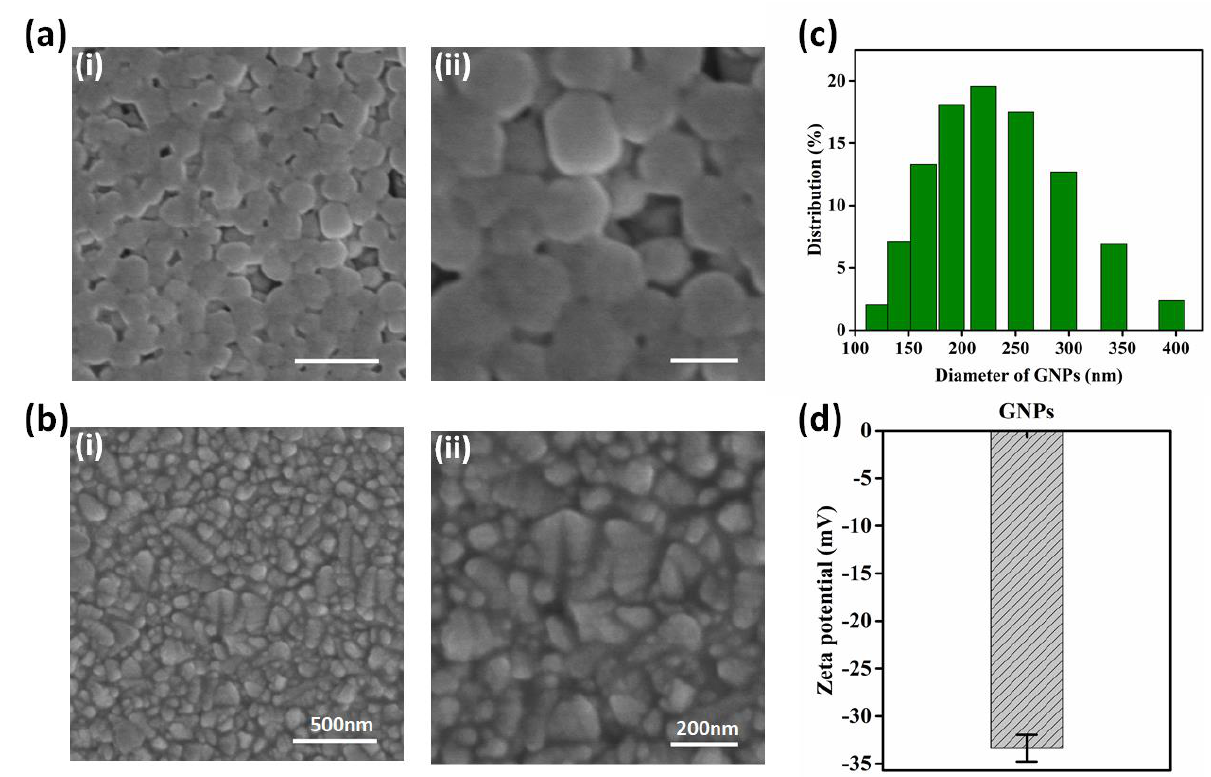
Figure 2. Characterization of GNPs and substrate. ( a , b ) SEM images of GNPs – coated substrate and bare FTO substrate; scale bars in ( i ) and ( ii ) are 500 nm and 200 nm, respectively. ( c ) DLS analysis of GNP diameter distribution; the centralized size is between 150 and 300 nm. ( d ) Zeta potential of GNPs, showing its stability (n = 3).